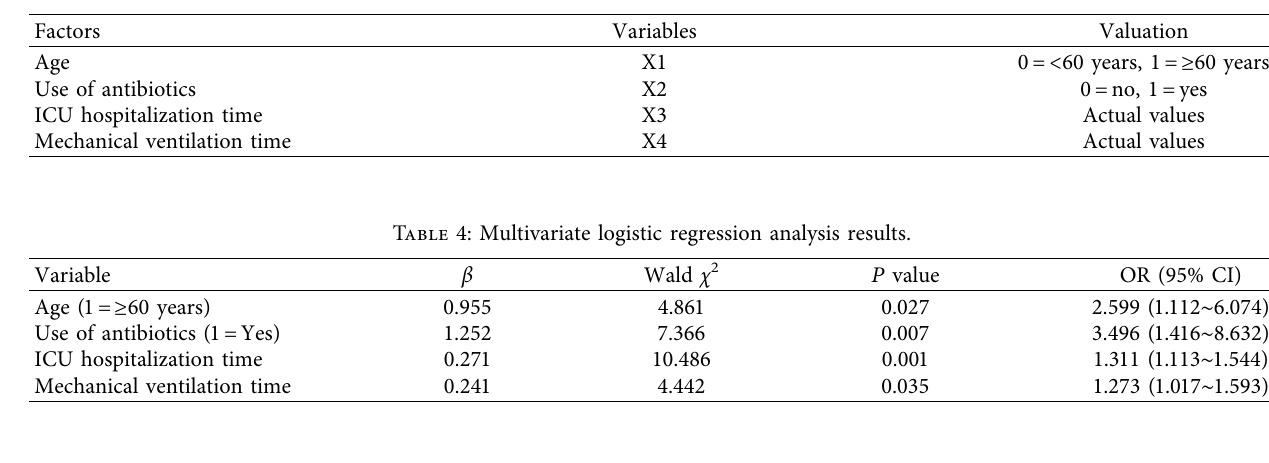
Table 3: Variable valuation.